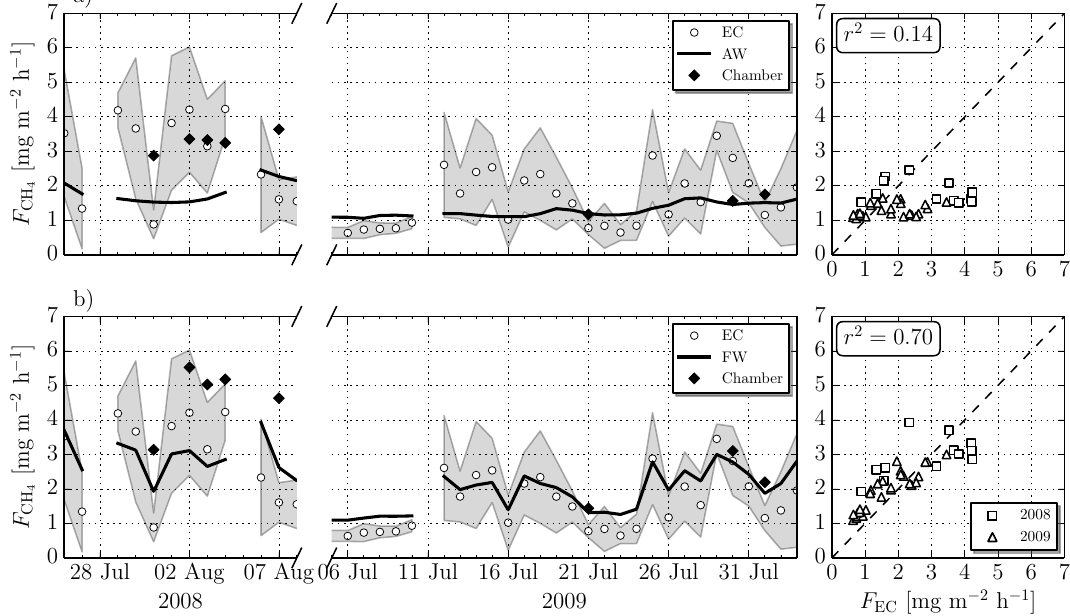
Figure 8. Temporal dynamics of the methane fluxes as measured with the EC system (white circles), modelled calculated fluxes (black lines) and upscaled chamber measurements (black diamonds) using (a) the AW approach and (b) the FW approach for years 2008 and 2009. Shaded areas represent one standard deviation of daily samples of the EC measurements. Scatter plots on the right-hand side show EC flux vs. modelled (a) AW and (b) FW flux